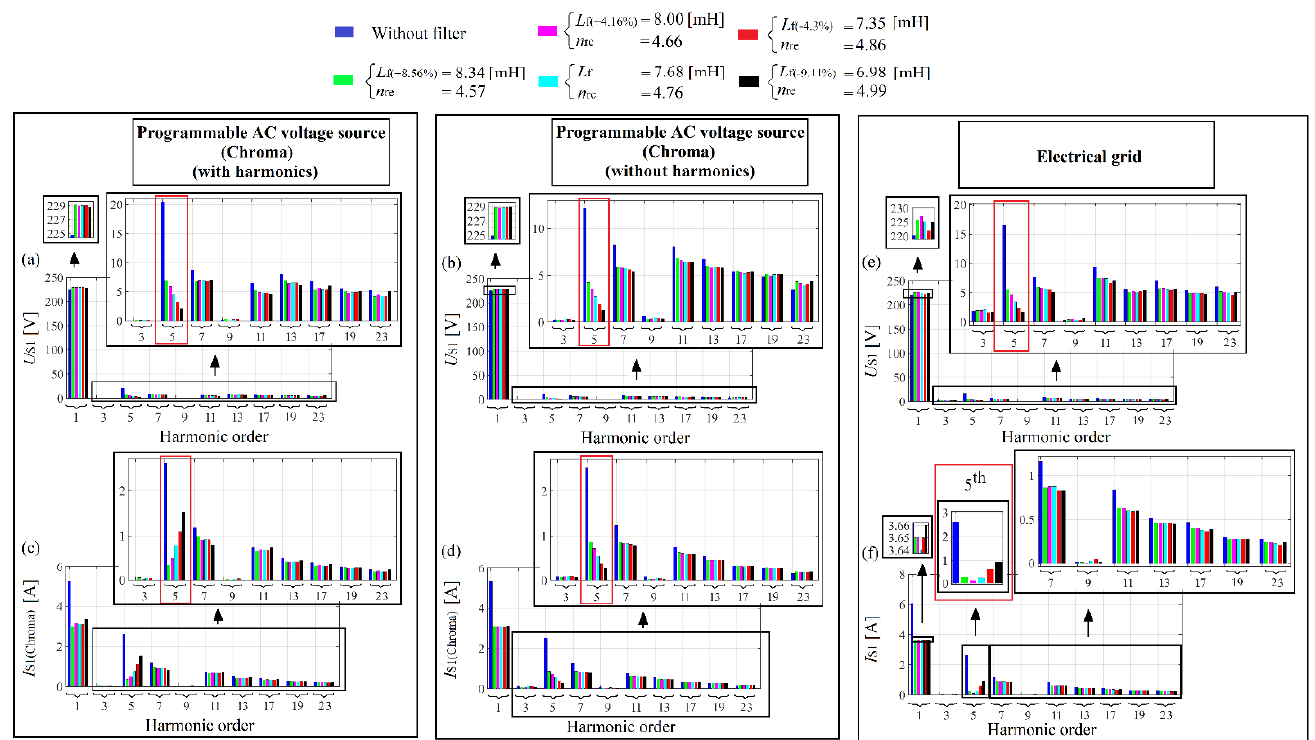
Figure 67. Summary comparison graphs presenting the behavior of the 5th harmonic in the voltage spectrums ( a , b , e ) as well as in the current spectrums ( c , d , f ) during the filter detuning phenomena. In the case of the supply voltage without harmonics (Chroma), the amplitude of the 5th harmonic in the voltage spectrum is reduced in the same way as in the current spectrum. The graphs are well described in the text.